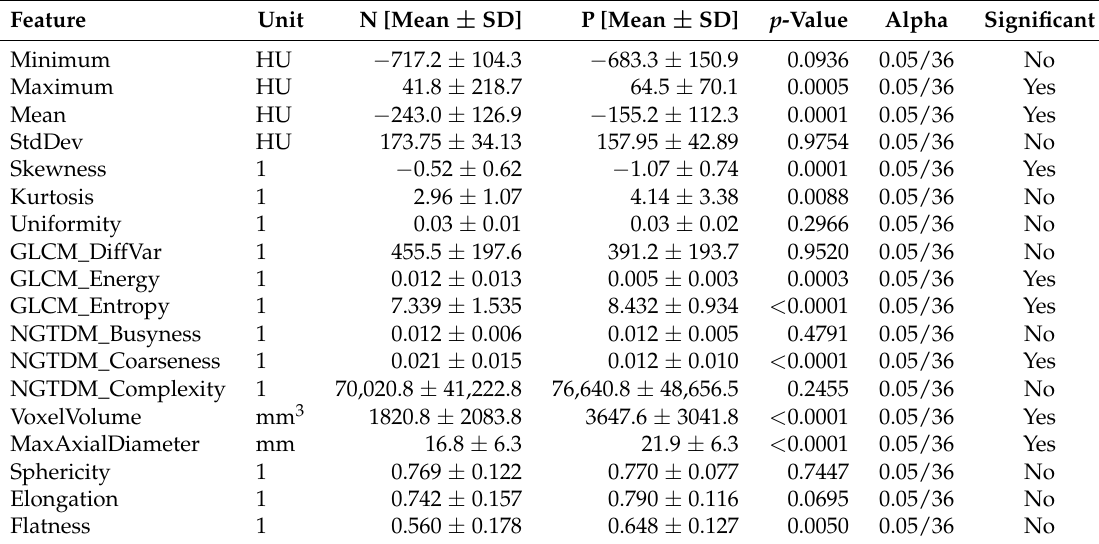
Table 3. Pairwise comparison between average feature values of CT radiomics features in the malignant (“P”) and benign (“N”) groups. Symbol “1” in the “Unit” column indicates a dimensionless feature.